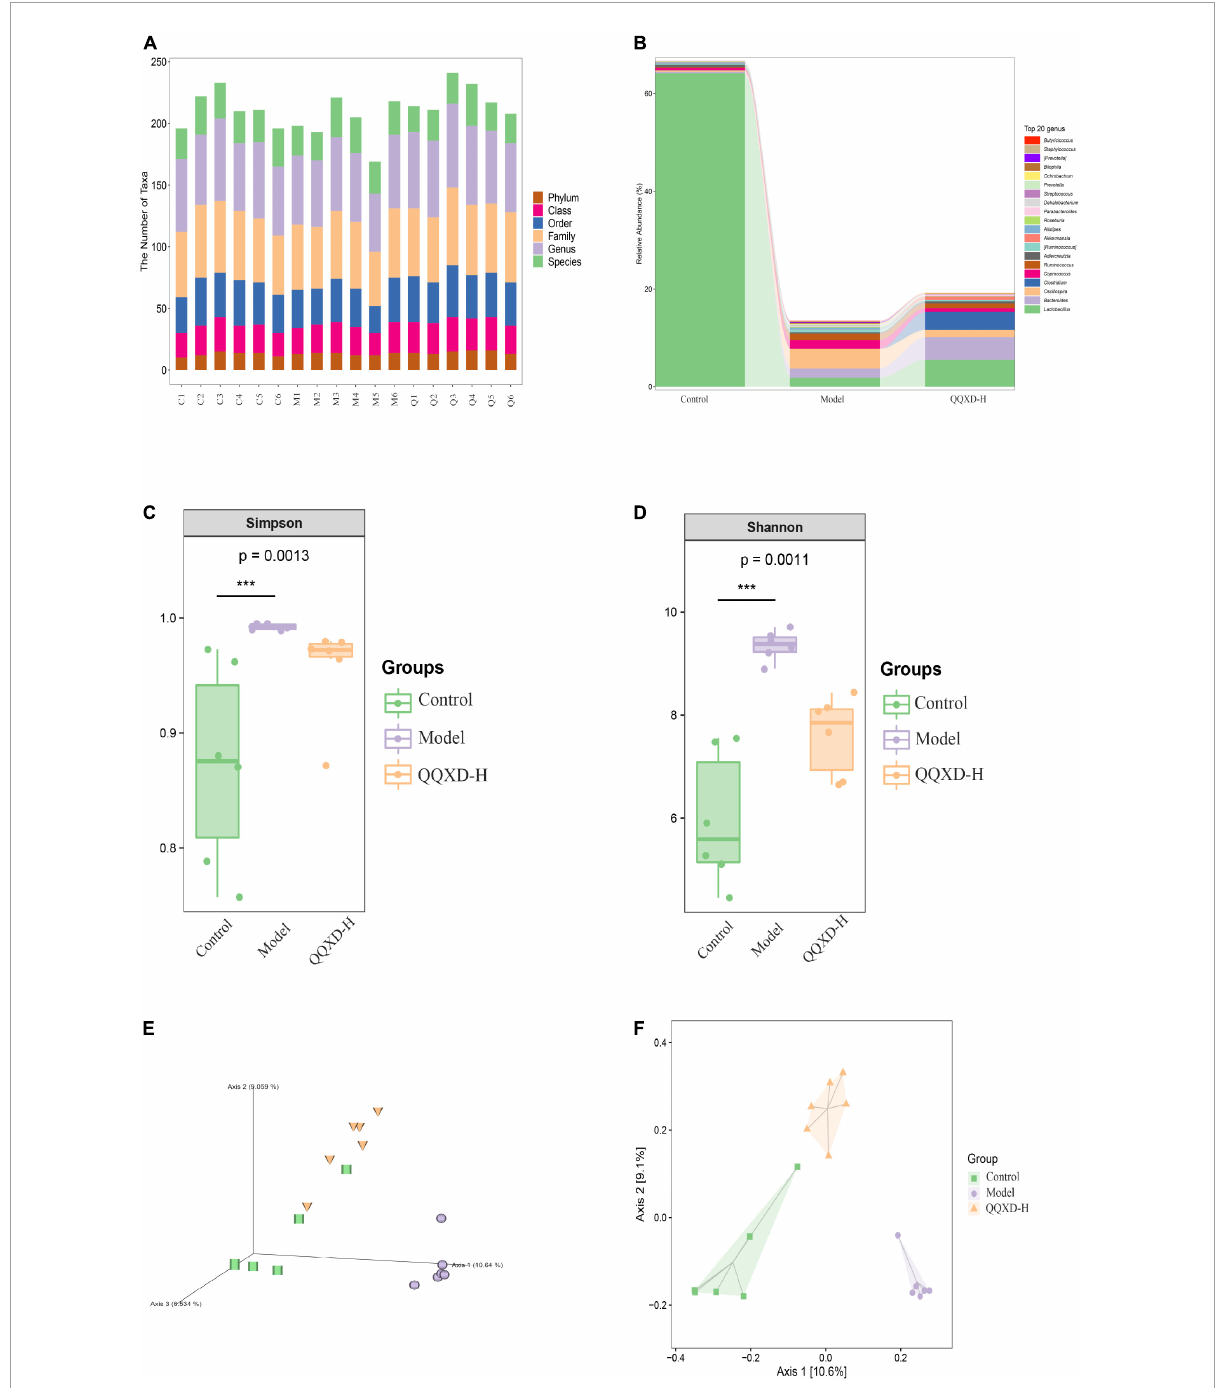
FIGURE4 Composition and diversity of intestinal flora in influenza mice treated with QQXD. (A) Statistical chart of the number of microbial taxonomic units at each level. Control: C1–C6; Model: M1–M6; QQXD: Q1–Q6. (B) Genus level species composition histogram. (C) Simpson index. (D) Shannon index. (E) Jaccard based PCoA 3D. (F) Jaccard based PCoA with hull 2D. *** p < 0.01.